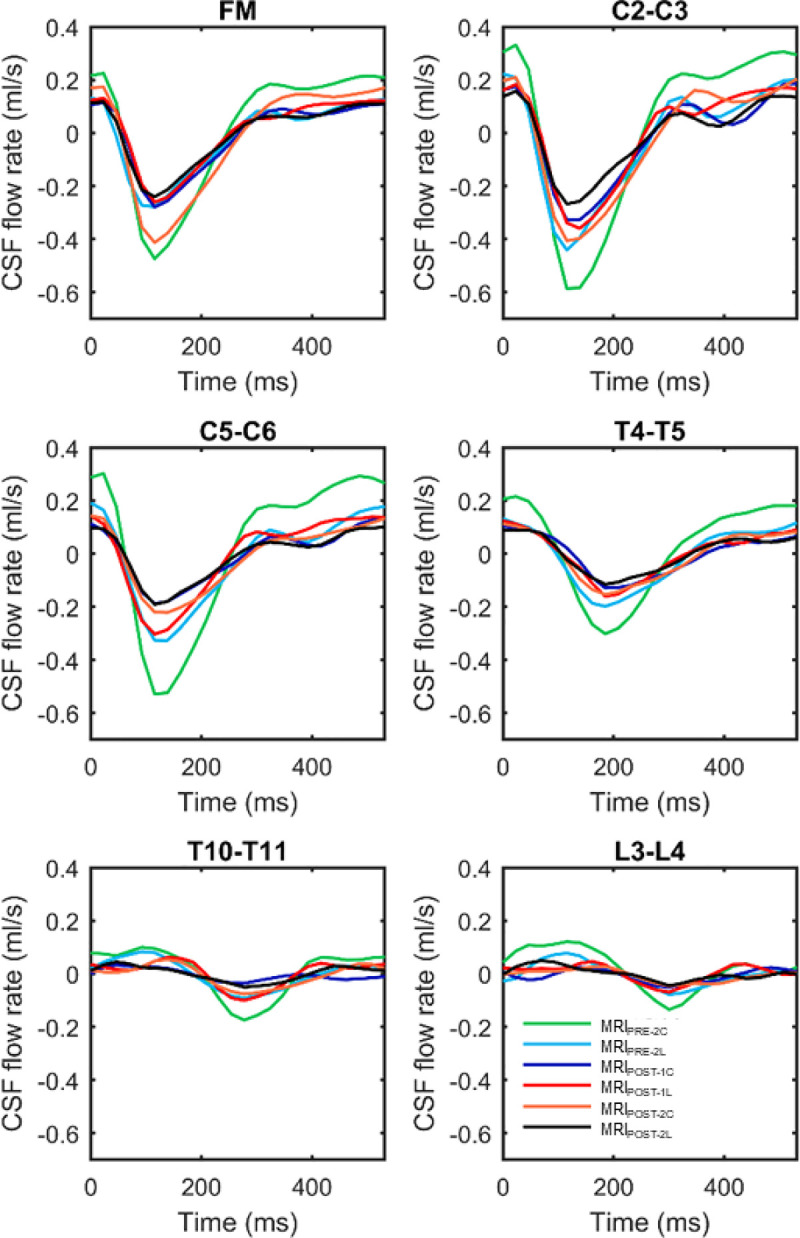
Average CSF flow waveforms for each MRI time point (4 NHPs at each point) measured at six axial locations along the spine (FM, C2-C3, C5-C6, T4-T5, T10-T11, L3-L4).Note: Peak systolic, CSF flow is in the caudal direction (negative values).